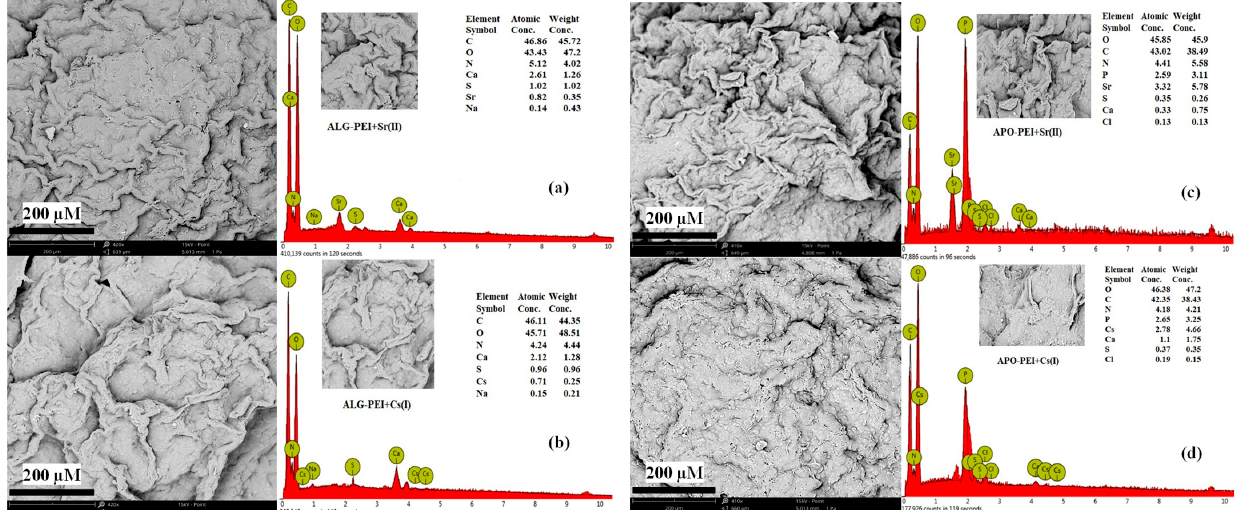
Figure A5. SEM observation ( left panels) and semi-quantitative EDX analysis ( right panels) of ALG- PEI after Sr(II) sorption ( a ) and Cs(I) sorption ( b ), and of APO-PEI after Sr(II) sorption ( c ) and Cs(I) sorption ( d ).